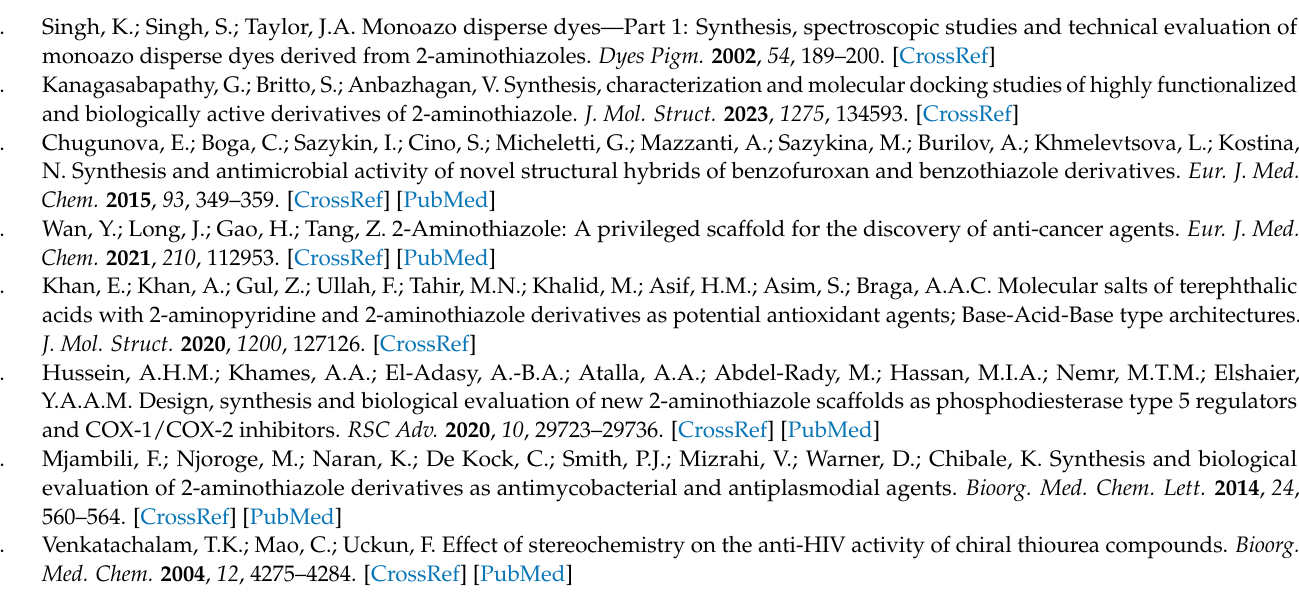
CDCl 3 of compound 3 ; Figure S2. NOE spectrum in CDCl 3 of compound 3 ; Figure S3. 13 C-NMR spectrum in CDCl 3 of compound 3 ; Figure S4. DEPT spectrum in CDCl 3 of compound 3 ; Figure S5. ESI-MS spectrum of compound 3